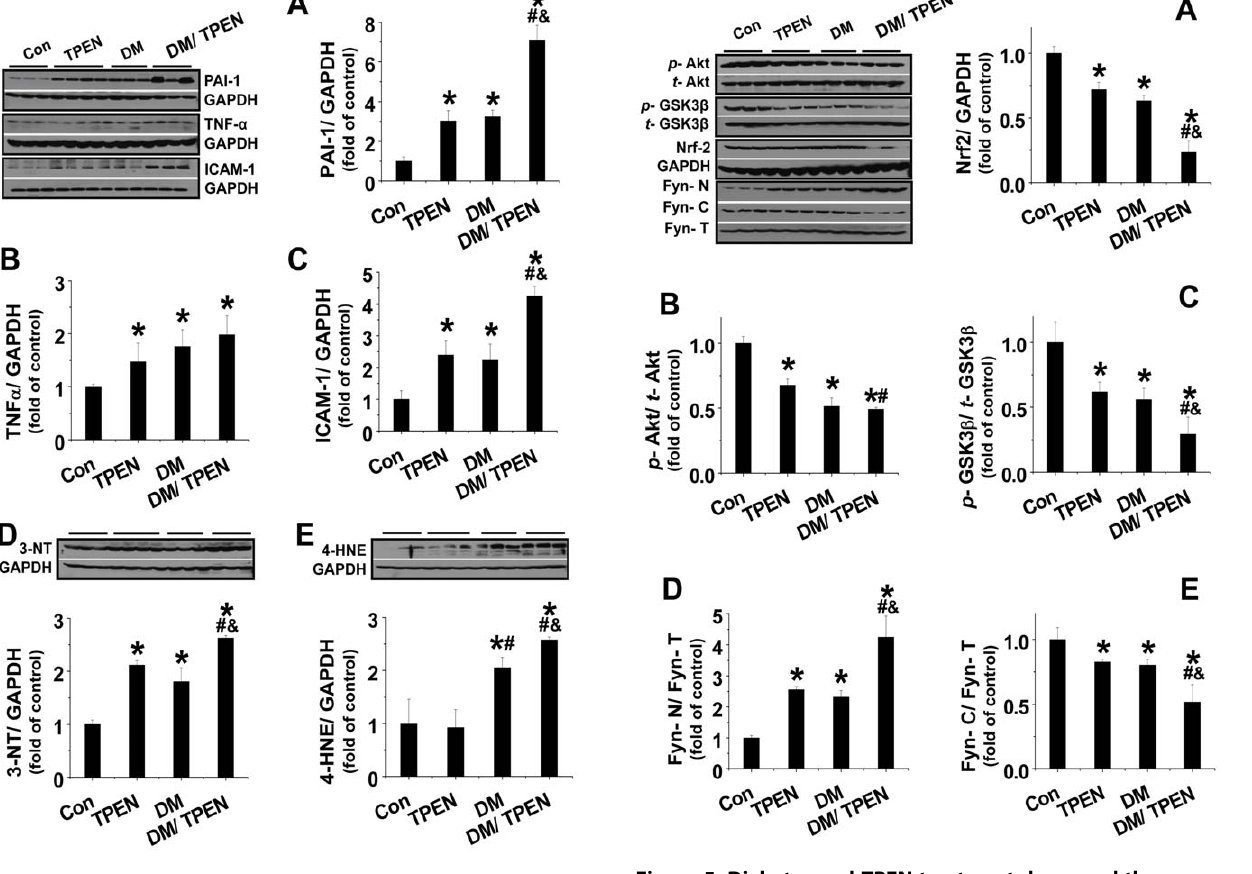
Figure 4. Effects of diabetes and TPEN on hepatic inflammation and oxidative damage. Hepatic expression of inflammatory factors, including PAI-1 (A), TNF- a (B), and ICAM-1 (C) was examined by Western blotting. Hepatic oxidative damage was examined by Western blotting assay for the expression of 3-NT as an index of protein nitration (D) and 4-HNE as an index of lipid peroxidation (E). Data are presented as mean 6 SD (n=6 at least in each group). DM: diabetes. * P , 0.05 vs. control group; # P , 0.05 vs. TPEN group; & P , 0.05 vs. DM group.